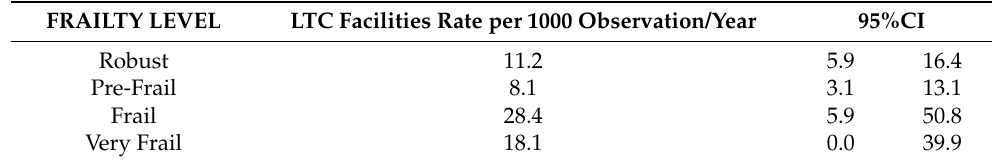
Table 2. LTC facilities rate per 1000 observation/year stratifies for frailty level.